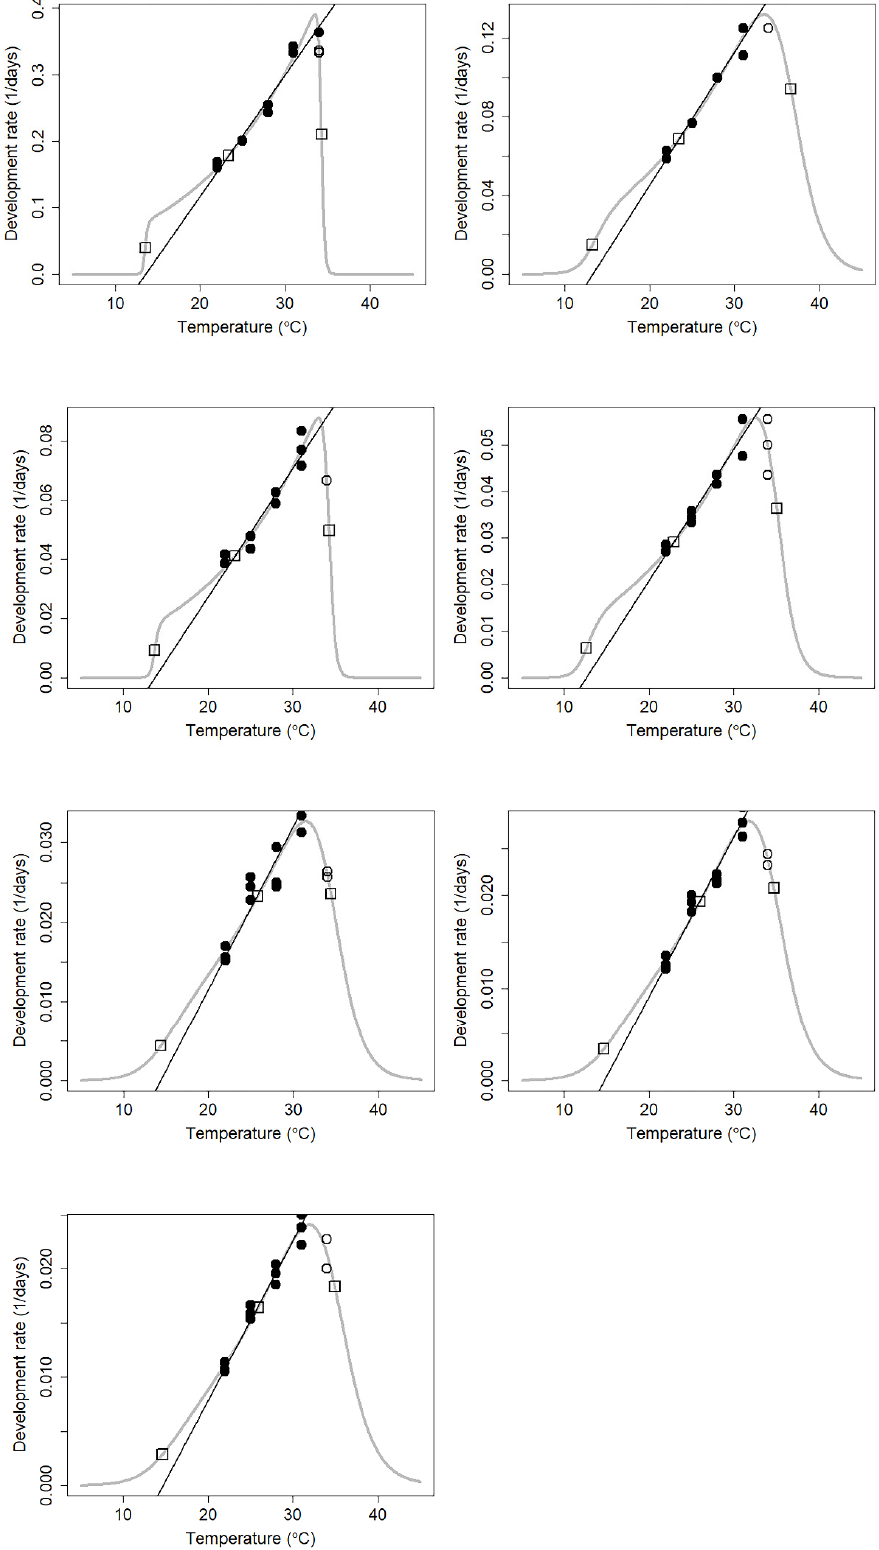
Figure 4. Nonlinear thermodynamic Optim SSI models of the seven developmental stages of Necrobia ruficollis circles indicate data points. The curved line indicates the developmental rate predicted by the Optim SSI model of Shi et al. [46]. The three open squares denote the predicted mean developmental rates at T L , T Φ , and T H . The black circles denote the data used for the linear fitting by the reduced major axis, whereas the white circles were the data excluded from the linear